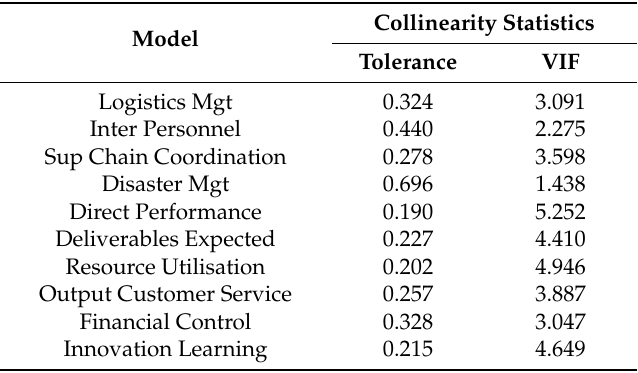
Table 3. Multicollinearity Statistics (Source: Survey data).